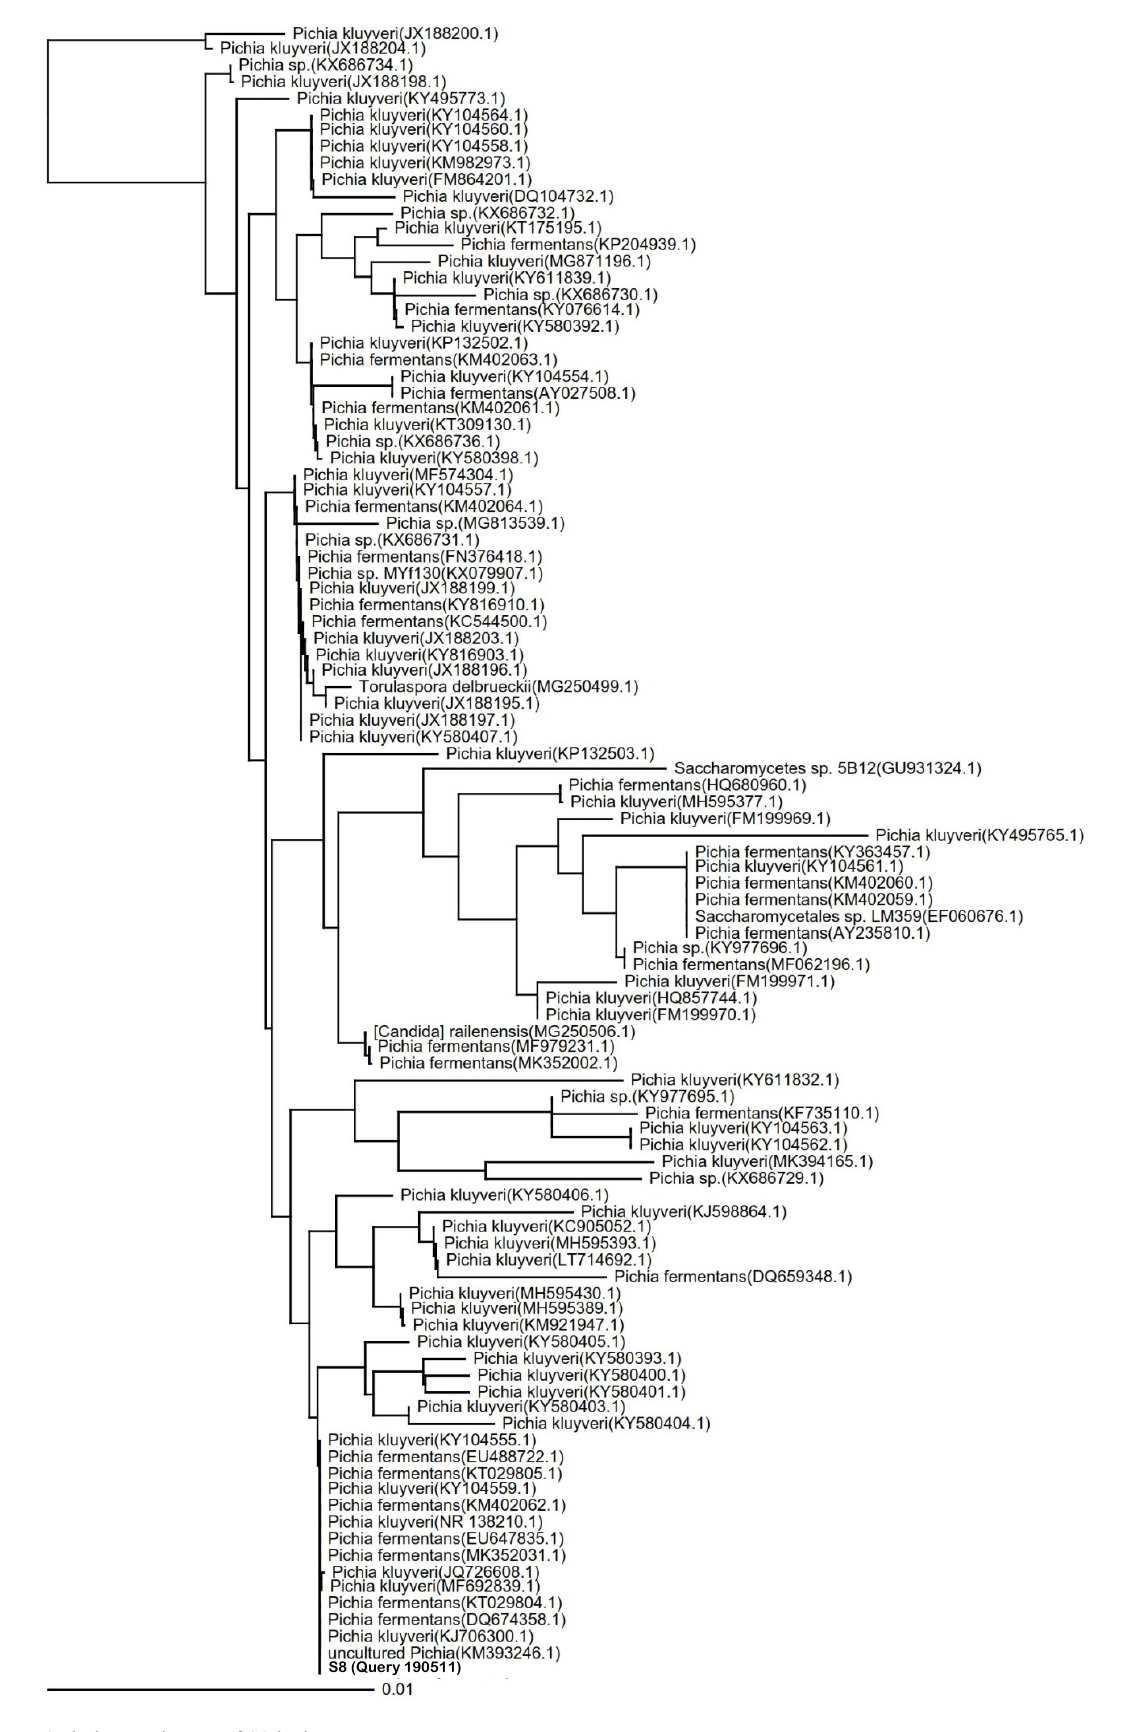
Figure 4 Phylogenetic tree of S8